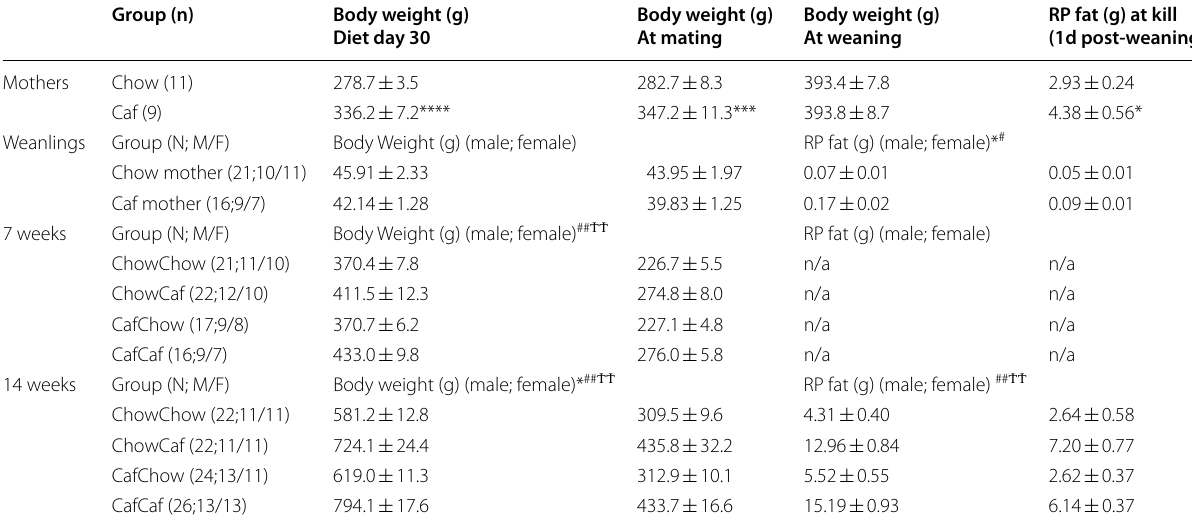
Data are displayed as mean